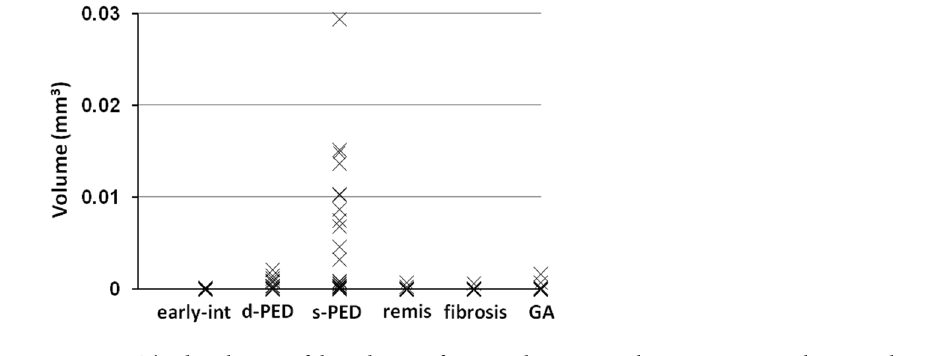
Figure 5. The distribution of the volumes of HRF with RPE in each AMD group. Early-int, early to intermediate AMD; d-PED, drusenoid PED; s-PED, serous PED; remis, remission stage of exudative AMD; fibrosis, the end-stage of AMD with subretinal fibrosis; GA, dry AMD with geographic atrophy. All abbreviations used are as defined in the figure legends for Figs 1–4.